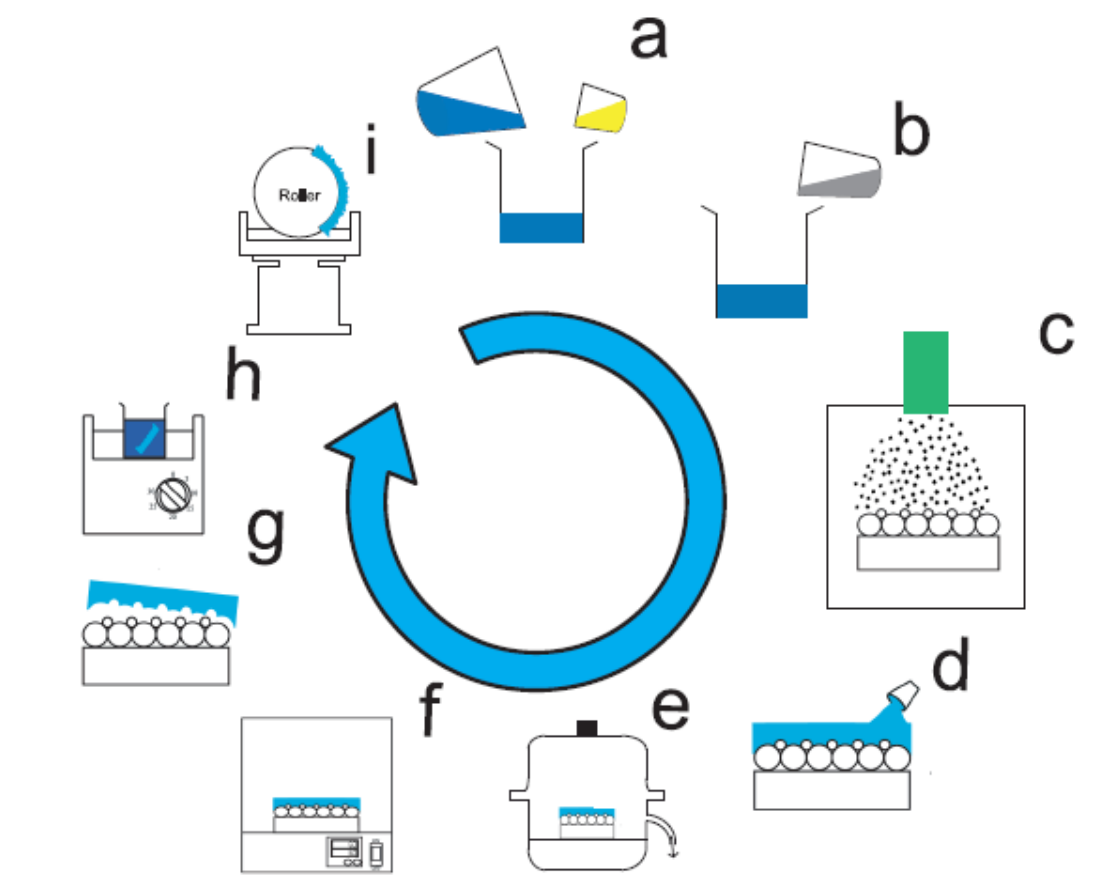
Figure 2. Schematic prepation of soft mold.